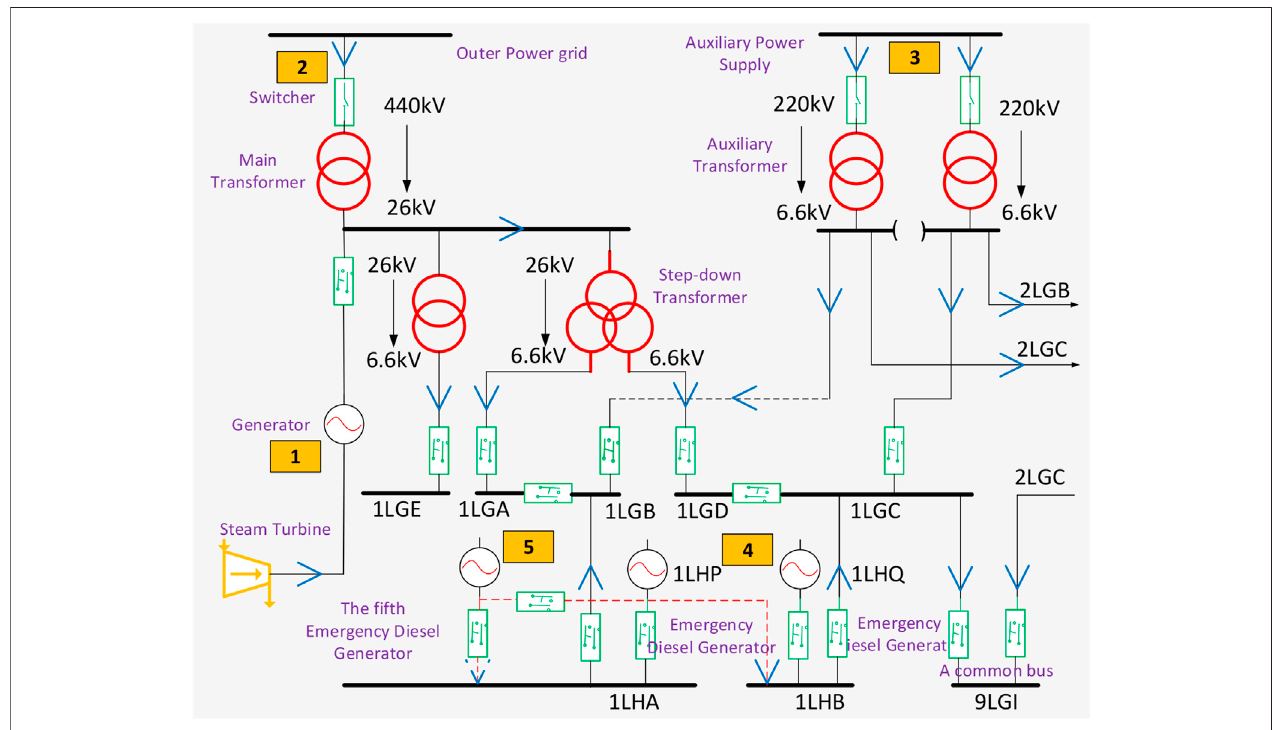
FIGURE 2 | Structure scheme of power supply system in one Chinese 1000MWe